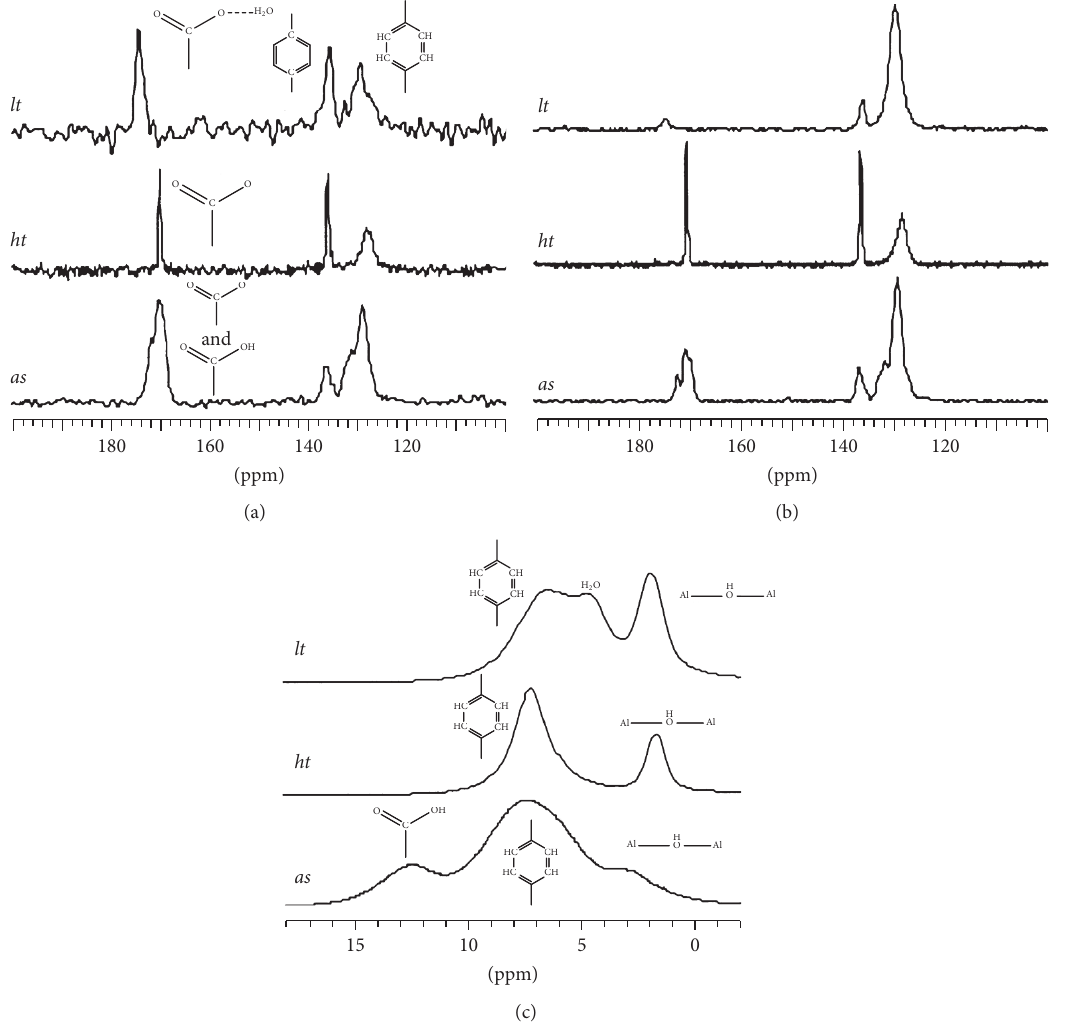
Figure 4: (a) 13 C DPMAS NMR spectrum, (b) 13 C CPMAS NMR spectrum, and (c) 1 H MAS NMR spectrum of MIL-53 in different phases. Reprinted with permission from Ref. [8]. Copyright 2004 John Wiley and